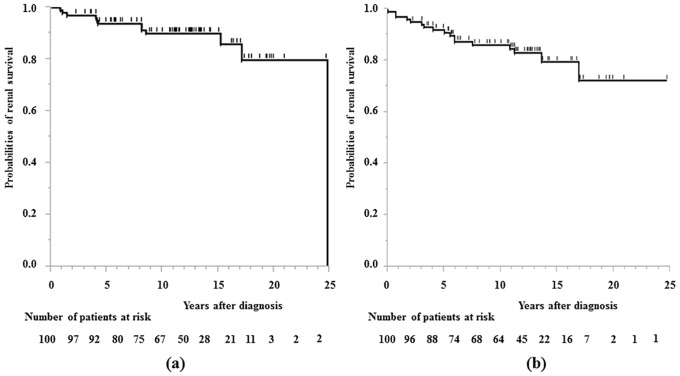
Renal survival curve of all patients.a) Kaplan-Meier plot showing time to ESKD. b) Kaplan-Meier plot showing time to CR.